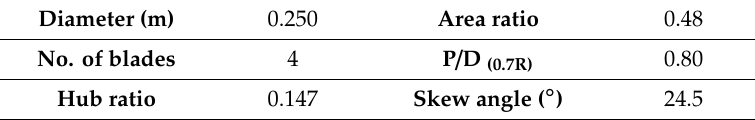
Table 2. Principal parameters of YUPENG propeller